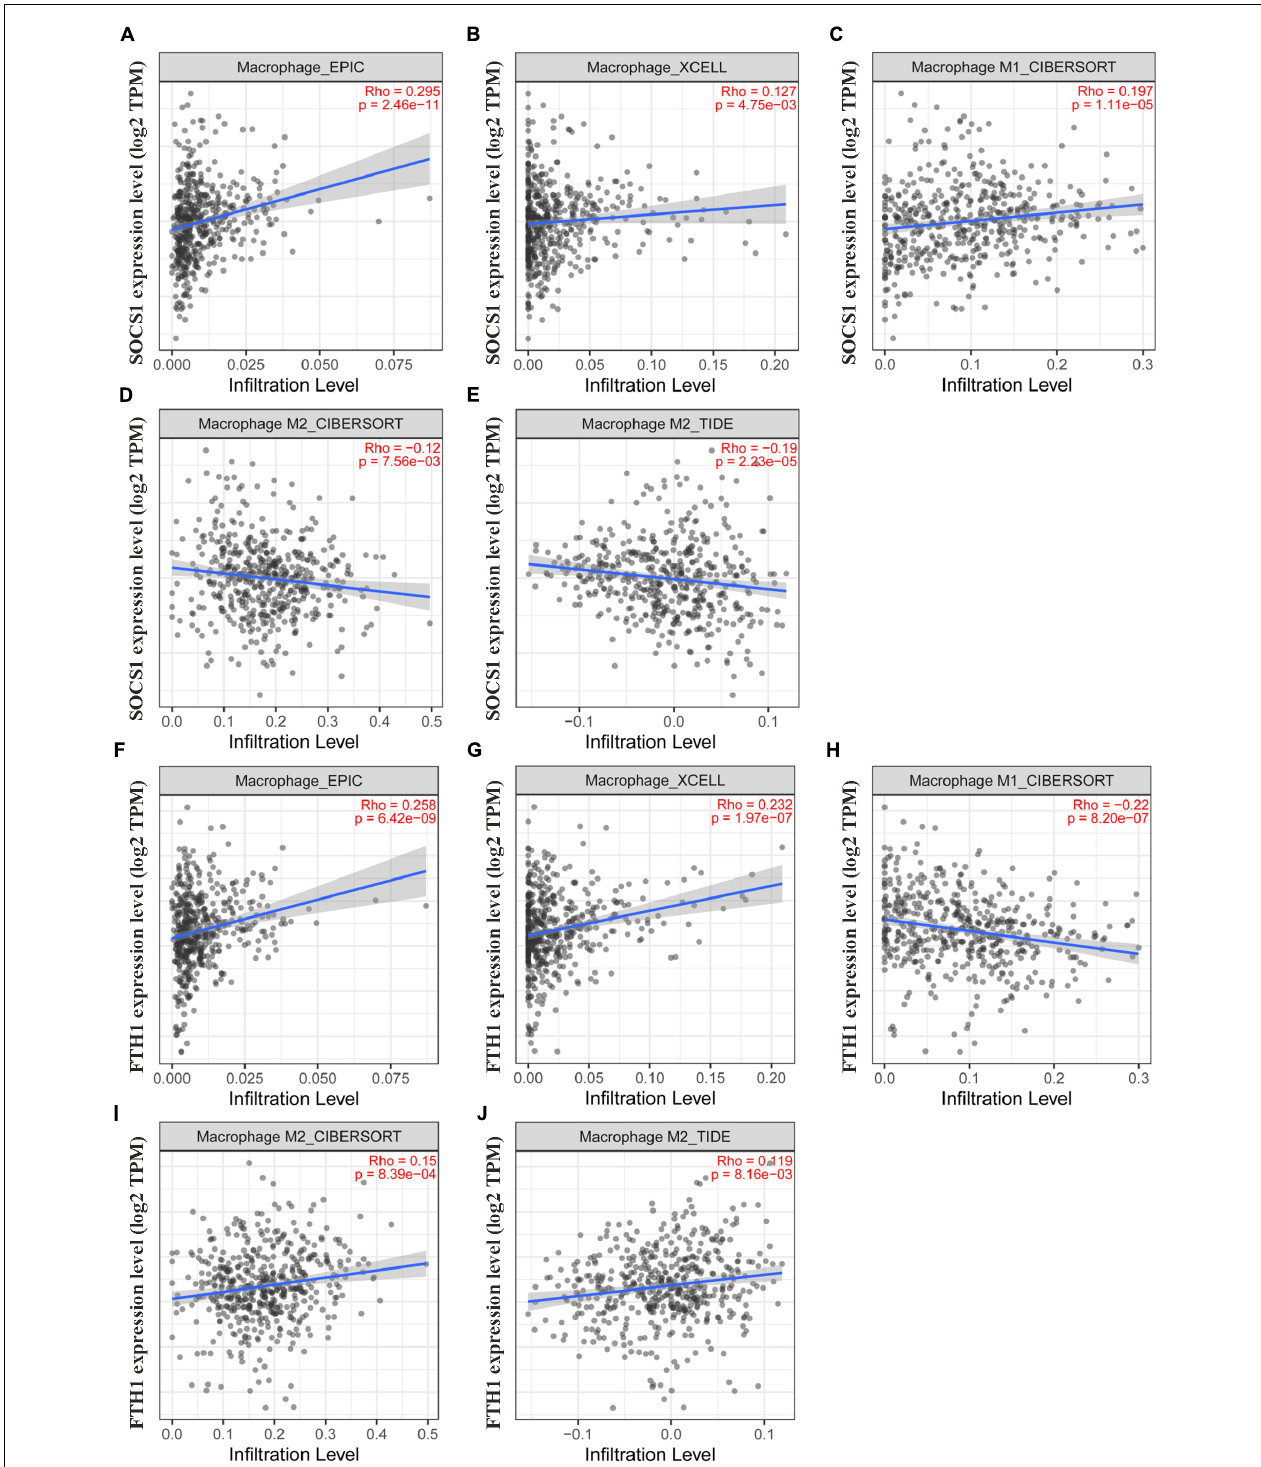
FIGURE 7 | Validation of the significant correlations between SOCS1 and FTH1 expression and macrophages (TIMER2.0). (A) EPIC, SOCS1 , and macrophages ( R = 0.295, p = 2.46 × 10 − 11 ). (B) XCELL, SOCS1 , and macrophages ( R = 0.127, p = 4.75 × 10 − 3 ). (C) CIBERSORT, SOCS1 , and M1 macrophages ( R = 0.197, p = 1.11 × 10 − 5 ). (D) CIBERSORT, SOCS1 , and M2 macrophages ( R = –0.12, p = 7.56 × 10 − 3 ). (E) TIDE, SOCS1 , and M2 macrophages ( R = –0.19, p = 2.23 × 10 − 5 ). (F) EPIC, FTH1 , and macrophages ( R = 0.258, p = 6.42 × 10 − 9 ). (G) XCELL, FTH1 , and macrophages ( R = 0.232, p = 1.97 × 10 − 7 ). (H) CIBERSORT, FTH1 , and M1 macrophages ( R = –0.22, p = 8.2 × 10 − 7 ). (I) CIBERSORT, FTH1 , and M2 macrophages ( R = 0.15, p = 8.39 × 10 − 4 ). (J) TIDE, FTH1 , and M2 macrophages ( R = 0.119, p = 8.16 × 10 − 3